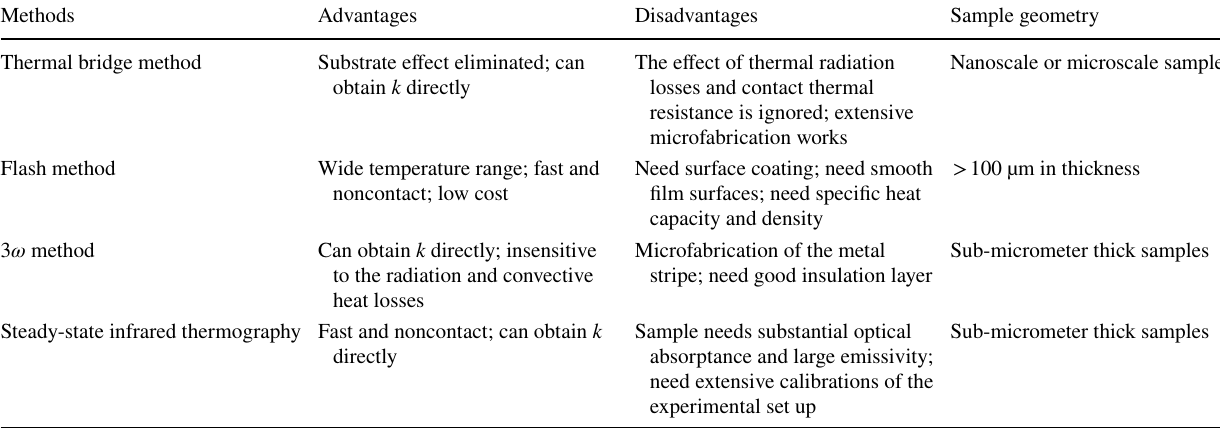
Table 1 The comparison of advantages and disadvantages of thermal technologies presented in the review to measure the in‑plane k of films [68, 73, 74] Methods Advantages Thermal bridge